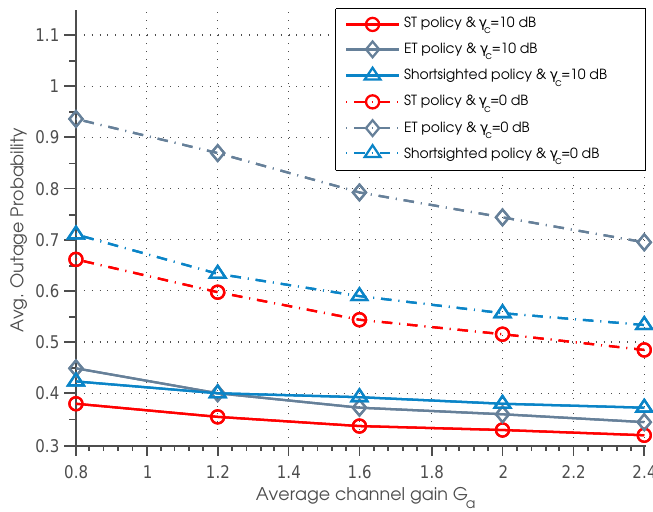
Figure 5. Average outage probability vs. average channel gain.